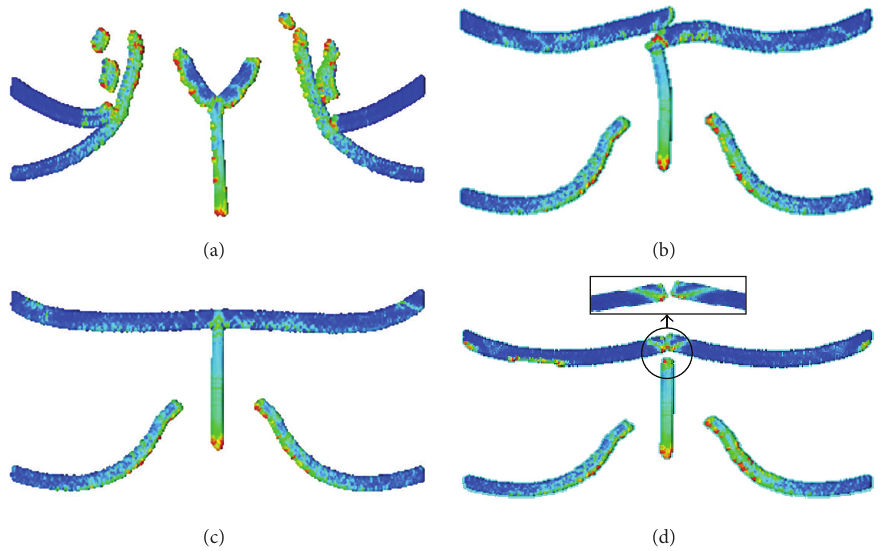
Figure 16: Failure modes of different coated shells at about 2 ms; (a)–(d) mean no-covering (no interlayer water), no-covering (full interlayer water), in-covering of inner shell (full interlayer water), and out-covering of inner shell (full interlayer water).